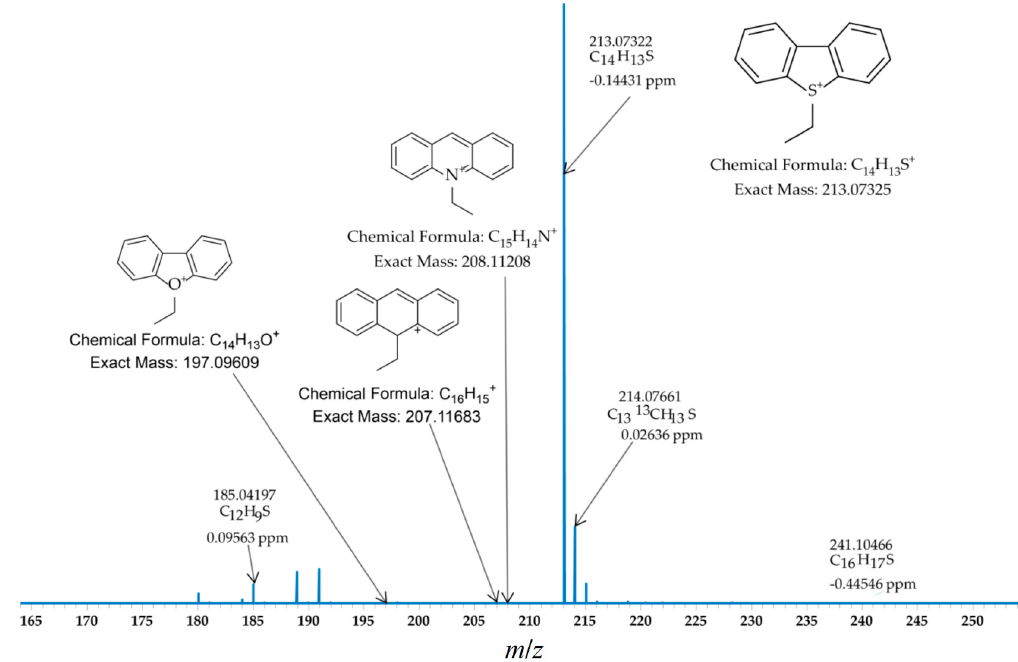
Figure 2. ESI FT-ICR MS spectrum of a mixture of the ethylated standards (anthracene (ANTH), DBT, acridine (ACR) and dibenzofuran (DBF)).